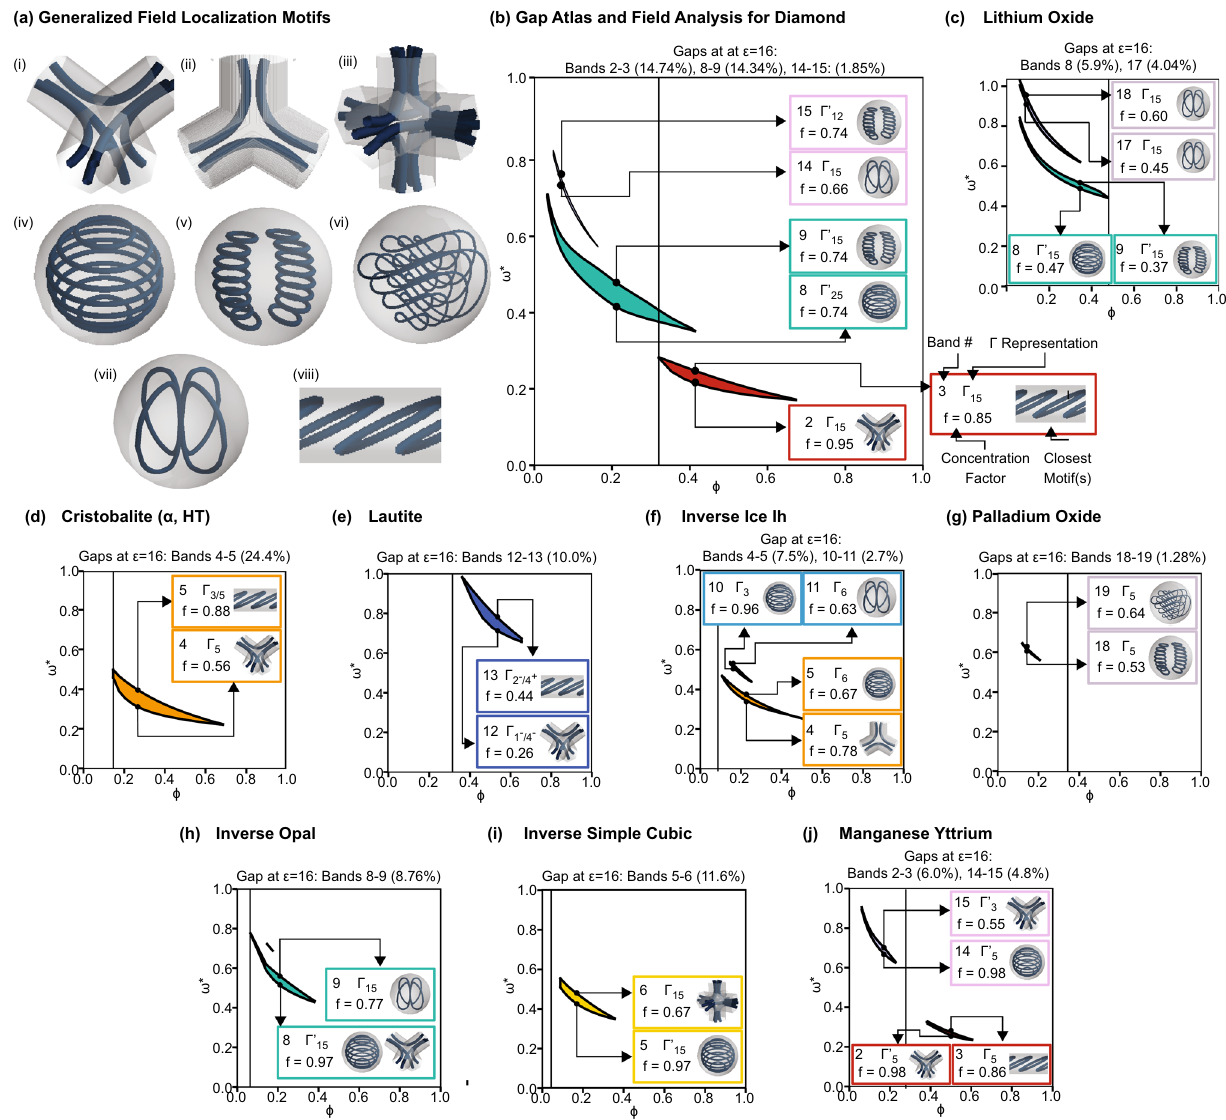
Fig. 3 Mode con fi gurations and motifs for PBG photonic crystals. a Common motifs in the mode conformations of PBG photonic crystals. Motifs (i – iii) exhibit regions of high electric energy density between adjacent unit cells, while the electric energy density for modes (iv – viii) is con fi ned to an isolated region of dielectric material. b Gap atlas and fi eld analysis of diamond, which has two large PBGs at different regions of fi lling fraction, either between bands 2 – 3 or 8 – 9, and a small PBG between bands 14 – 15. The dotted line denotes the fi lling fraction at which the dielectric has formed a continuous network. c Gap atlas and fi eld analysis of lithium oxide, which has two PBGs at different regions of fi lling fraction, either between bands 8 – 9 or 17 – 18. The dotted line denotes the fi lling fraction at which the dielectric has formed a continuous network. d – j Gap atlases and fi eld analyses for α -cristobalite ( cF 24), lautite ( oP 12), Ice Ih ( hP 30), palladium oxide ( tP 4), inverse opal ( cF 4), inverse simple cubic ( cP 1), and manganese yttrium ( tI